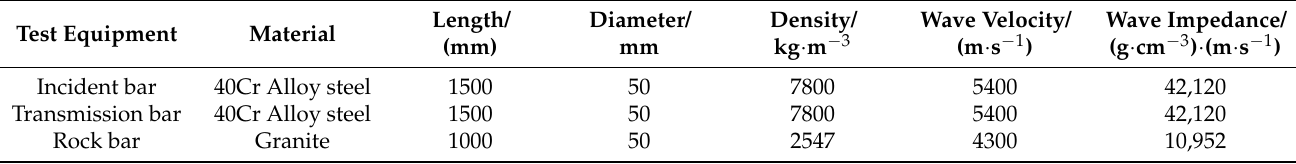
Table 2. Test equipment